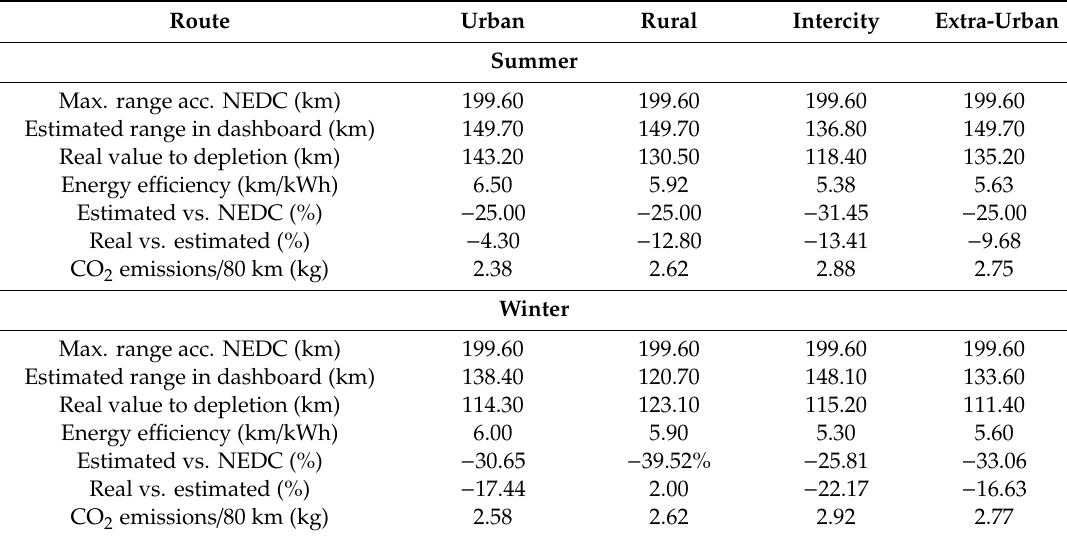
Table 5. Nissan Leaf range comparison for different routes.